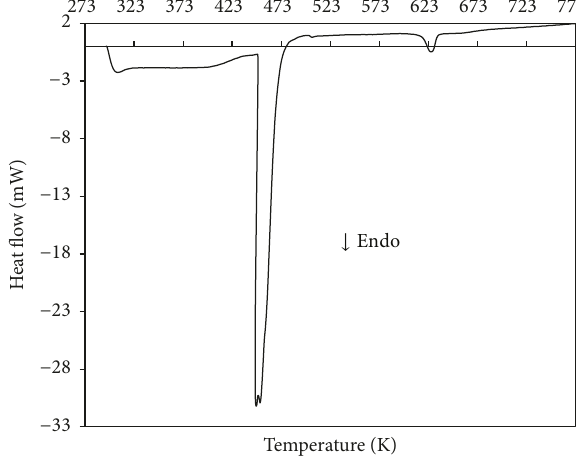
Figure 1: DSC lactic acid